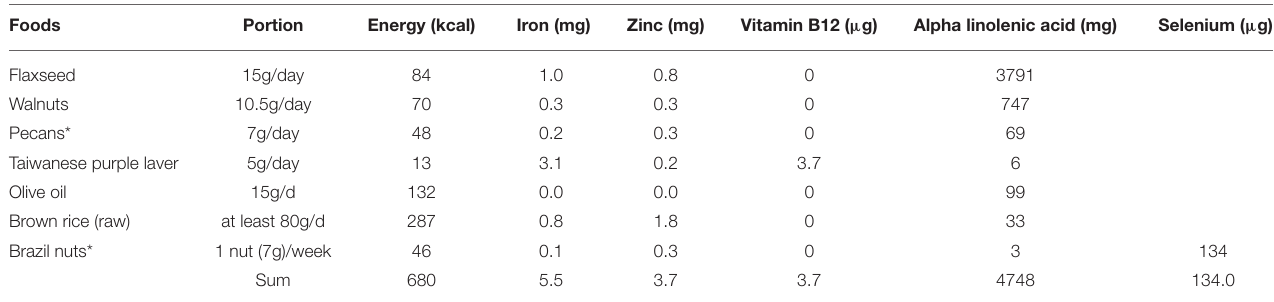
TABLE 1 | Amount and nutrient contents of foods provided in the intervention.